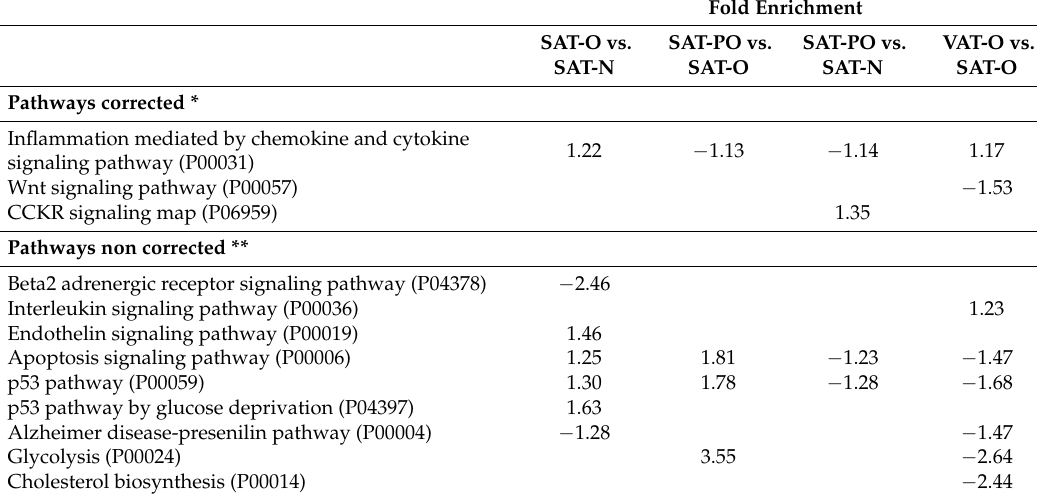
Table 4. Selected molecular pathways significantly regulated by differentially expressed miRNAs in subcutaneous (SAT) and visceral (VAT) adipose tissues of normal-weight (N), obese (O) and after weight loss (PO) individuals. Values presented as fold enrichment (values >1 correspond to the overrepresentation of the particular pathway while values <1 to its underrepresentation).